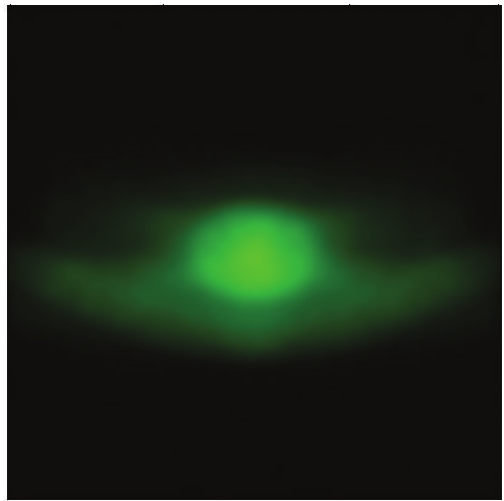
Figure 9: The light distribution of the simulation result.